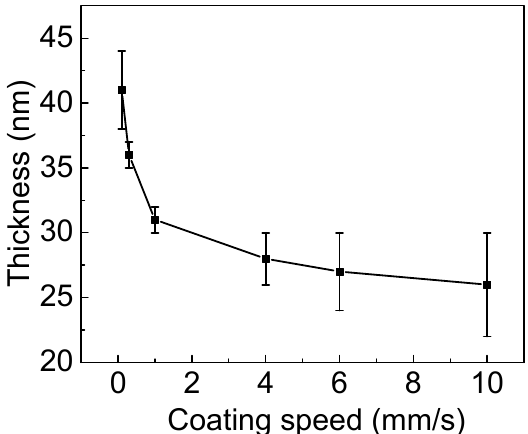
Figure 6. Thickness of PEDOT:PSS films that were deposited through a slot-die coating process at different coating speeds. The substrate temperature and flow rate were kept constant at 30 °C and 1 μL/s, respectively. The vertical bars indicate the range of variation of the films’ thickness in the same sample.